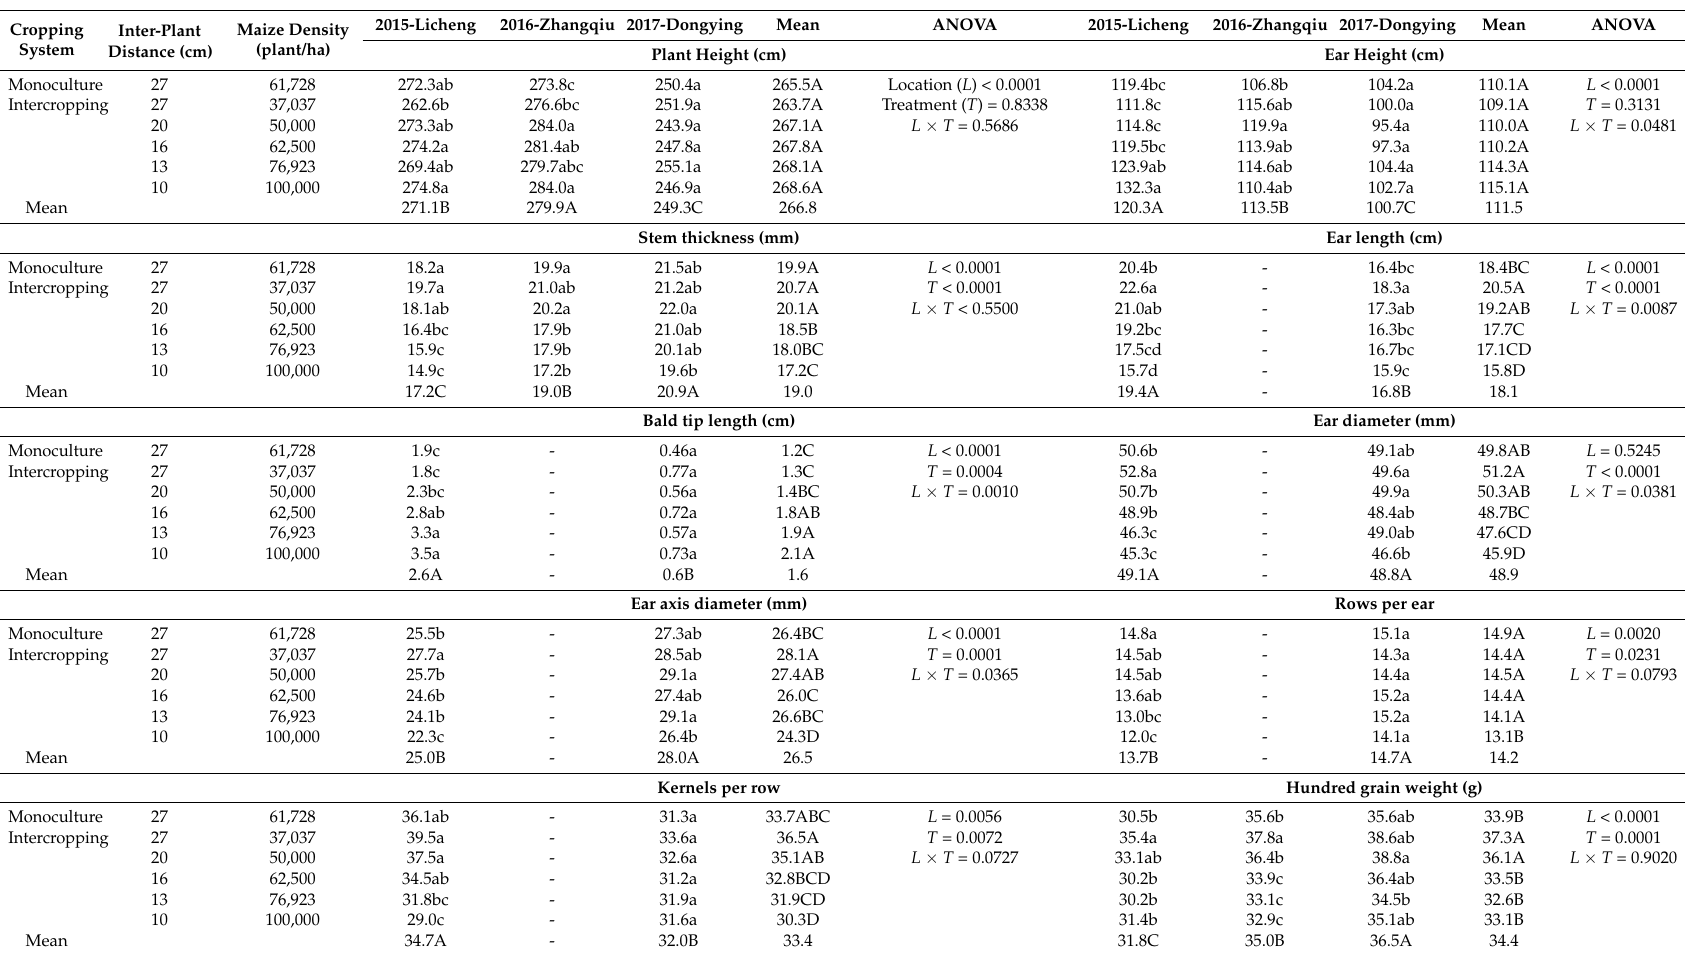
Table 5. Maize plant and ear traits as affected by different cropping systems and maize densities across different locations/years. Cropping